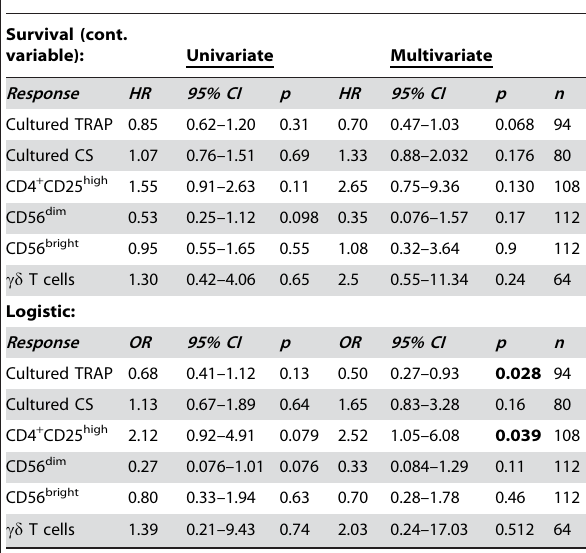
Table 2. Association between immune parameters and incidence of